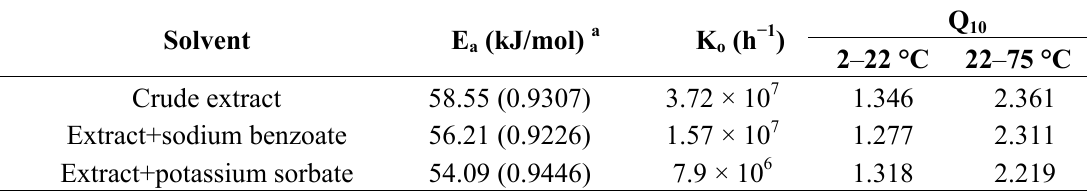
Table 2. Effect of temperature on the degradation of anthocyanins from Cornelian cherry fruits